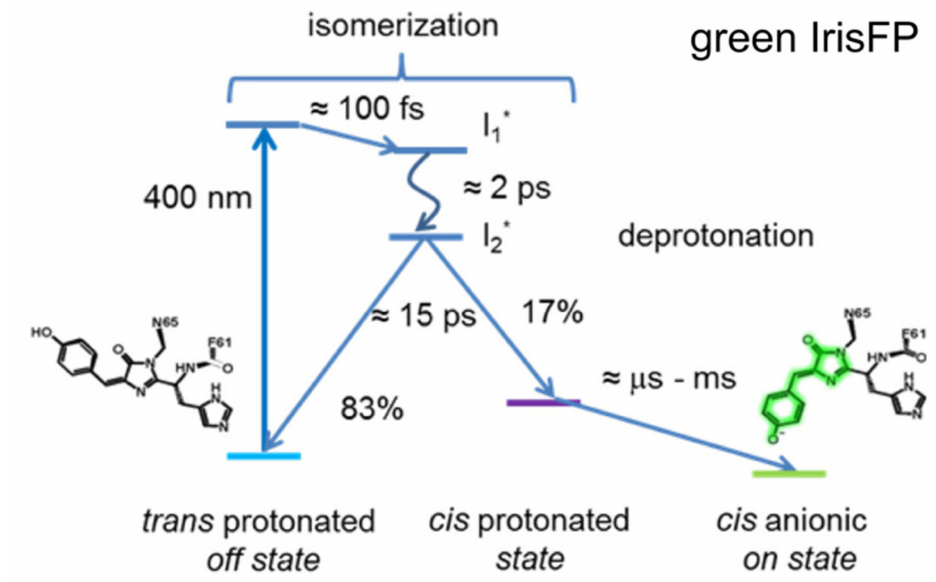
Figure 8. Photoactivation mechanism for green IrisFP in aqueous solution. Following 400 nm fs- laser excitation, the protein chromophore undergoes the excited-state trans -to- cis isomerization on the ps timescale while the deprotonation events occur on the µ s-to-ms timescales. The asterisk indicates the electronic excited state for the pertinent chromophore species. Chemical structures of the chromophores in the off (dark) and on (green) states are depicted. Reprinted with permission from Ref. [77]. Copyright 2016 American Chemical